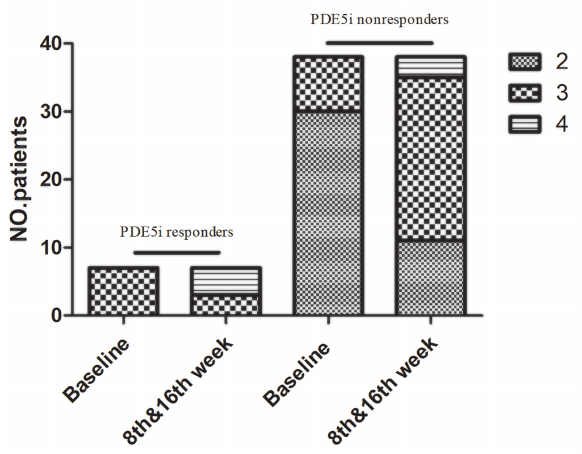
Figure 3 - PDE5i nonresponders will have PDE5i before assessment both in 8 th and 16 th week, but PDE5i responders